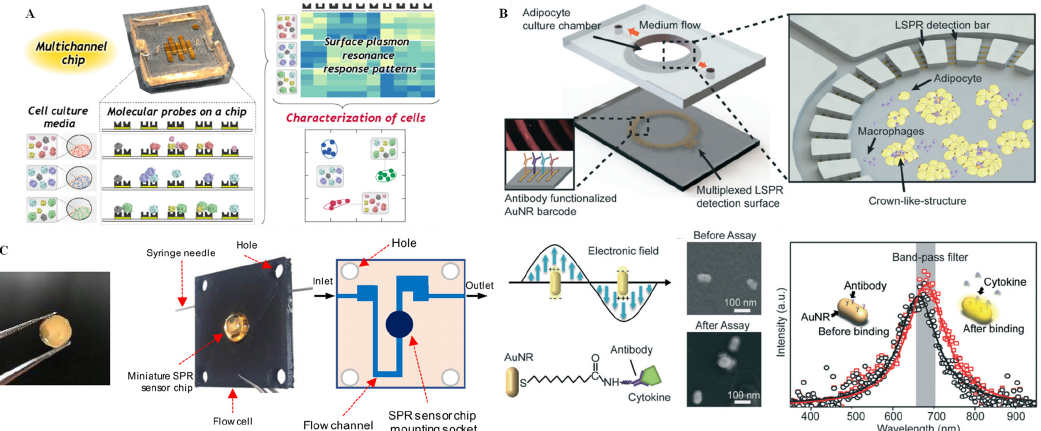
Figure 7. SPR technique for single-cell analysis on microchips. ( A ) Photograph of the multichannel chip and the SPR response patterns from the interactions between the molecular probes (cysteine derivatives) on the chip and the cell secretion components in the cell culture media. Reprinted with permission from ref. [78], Copyright 2020 American Chemical Society. ( B ) Schematic diagram of the miniature SPR sensor chip and the internal flow channel of the microfluidic flow cell. Reprinted with permission from ref. [80], Copyright 2019 American Chemical Society. ( C ) Overview of the chip design and the principle of cytokine detection on the AuNR-based LSPR sensor including SEM images and intensity data. Reprinted with permission from ref. [82], Copyright 2018, Royal Society of Chemistry.